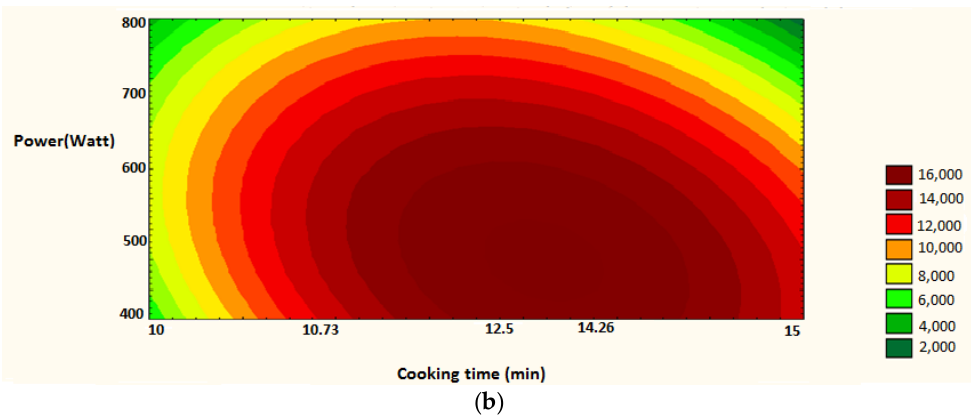
Figure 11. Surface plot and iso-response curve of polyphenols as a function of both factors time of cooking and microwave power. ( a ): surface plot; ( b ): iso-response curve. The optimum conditions obtained are as follows: cooking time: 13.23 min, power: 448.48 Watts (Figure 12), and the predicted polyphenol content is 16,210 µg GAE.